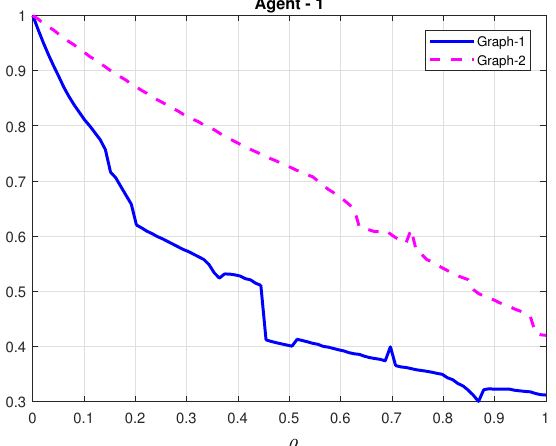
Figure 7. Ratio of broadcasting interacting signal and event-triggered criterion ρ by the ETM in Ref.